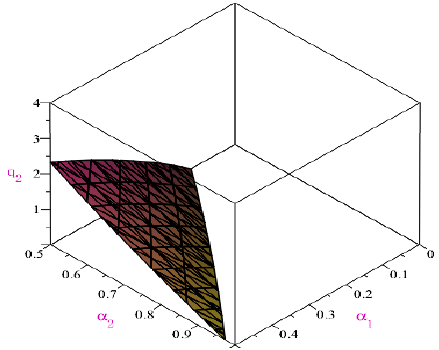
Figure 4. Changes of q ∗